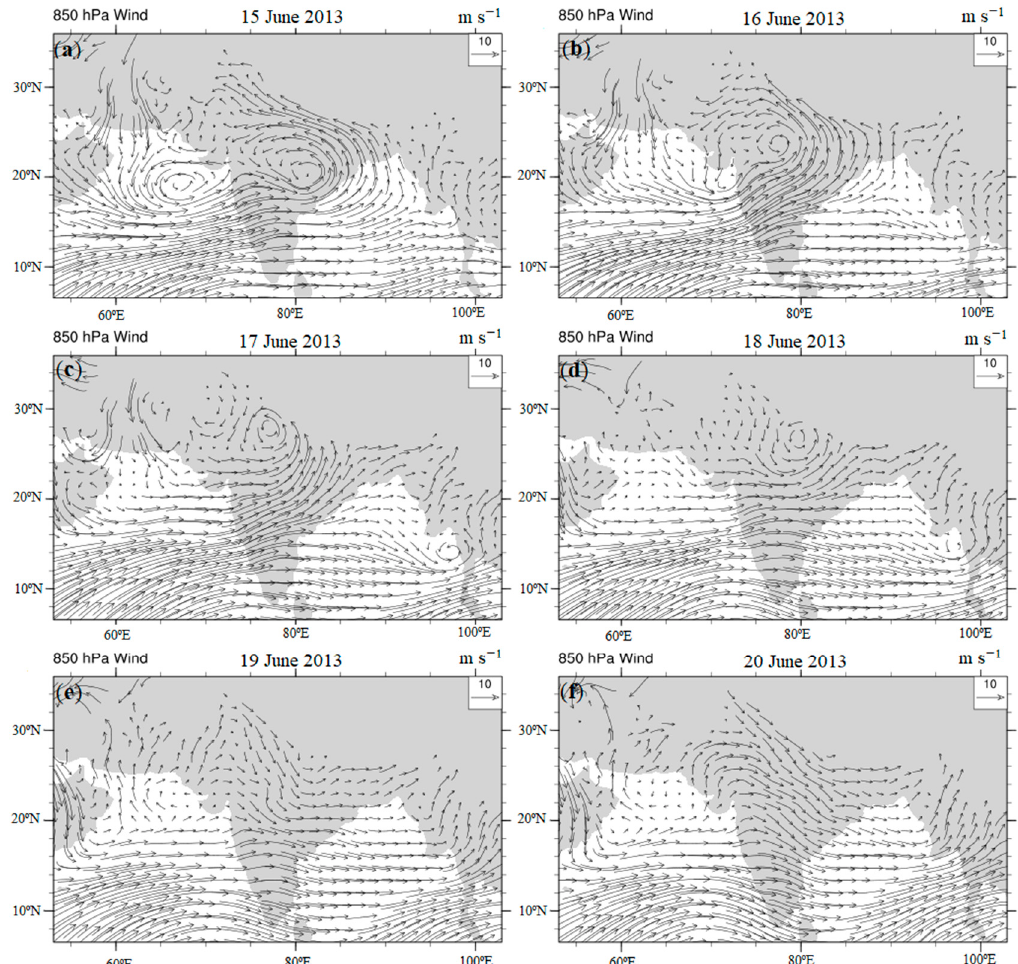
Figure 4. Daily wind speed at 850 hPa from 15–20 June ( a – f ). Simulation WC25.